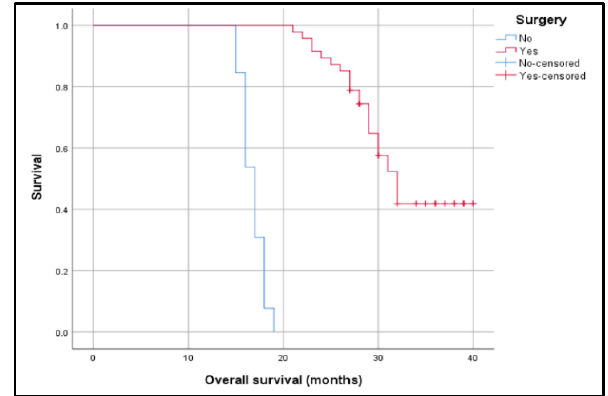
Figure 1. Overall survival curves according to surgical